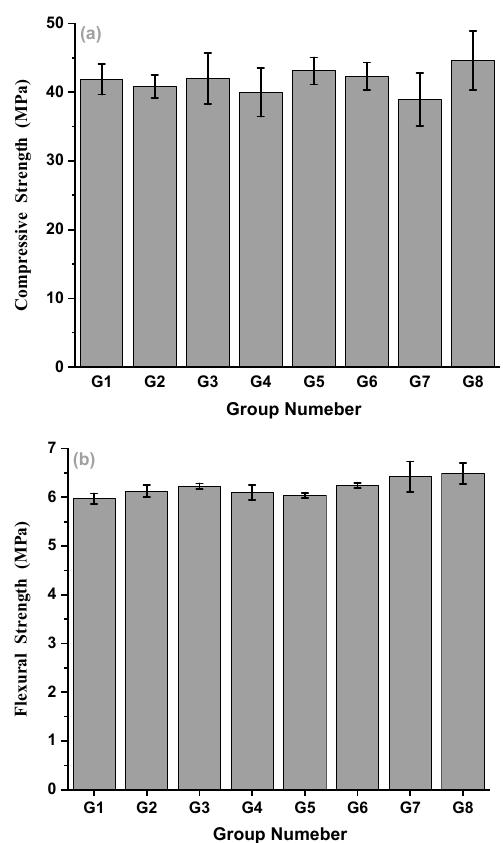
Figure 4. Compressive strength ( a ) and flexural strength ( b ) at 28 days.